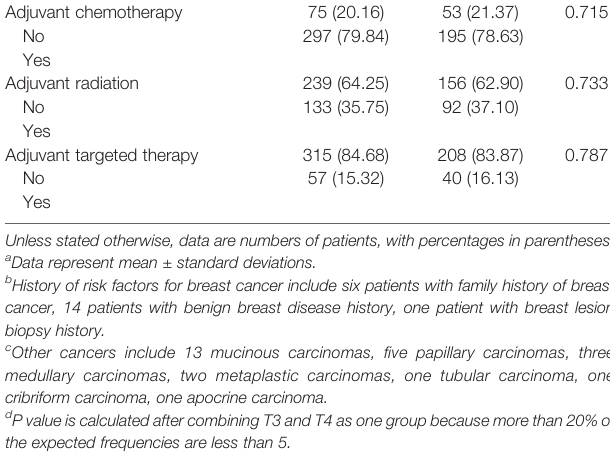
Totally, 14 features were selected from 1209 features to build radiomics signature in the training cohort ( Table S2 and Figure S4 ) and only one of them could distinguish patients with different prognoses ( Figures S5 , S6 ). The radiomics signature showed moderate performance on DFS estimation both in the training (C-index, 0.714; 95% con fi dence interval [CI], 0.63 – 0.80) and validation (C-index, 0.632; 95% CI, 0.52 – 0.74) cohorts. Based on the cutoff (1.816) of Rad-score ( Figure S7 ), patients with higher Rad-score ( ≥ 1.816) were divided into the high-risk group, whereas patients with lower Rad-score (<1.816) were divided into the low-risk group, and their characteristics are shown in Table 2 . The Rad-score prognostic accuracy determined by time- dependent receiver operator characteristics (ROC) curves and Kaplan – Meier survival curves are shown in Figure 1 . The radiomics signature was signi fi cantly associated with DFS in the training ( P < 0.0001) and validation ( P = 0.003) cohorts. The 5-year DFS of the high- and low-risk groups were 61.27% and 90.10% in the training cohort and 76.60 and 87.07% in the validation cohort, respectively. The distribution of the Rad-score and DFS are shown in Figures S8 – S9 , patients with higher Rad- score were more likely to experience events. Results of strati fi ed analysis based on molecular subtype are shown in Figure 2 . The Rad-score successfully discriminate prognoses in luminal B ( P = 0.00006) and triple-negative ( P = 0.00003), but failed in either luminal A ( P = 0.563) or HER2- enriched ( P = 0.109). The radiomics signature remained a statistically and clinically predictor in most subgroups based on clinicopathological variables ( Figure S10 ).